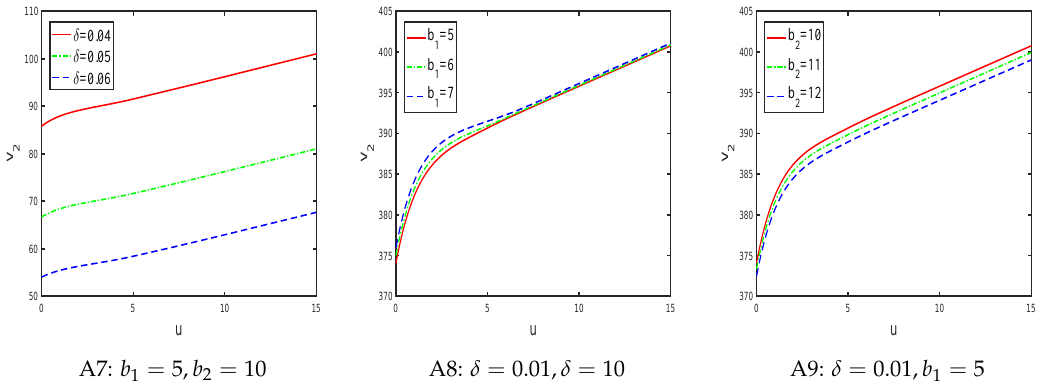
Figure 4. Expected discount dividend function until